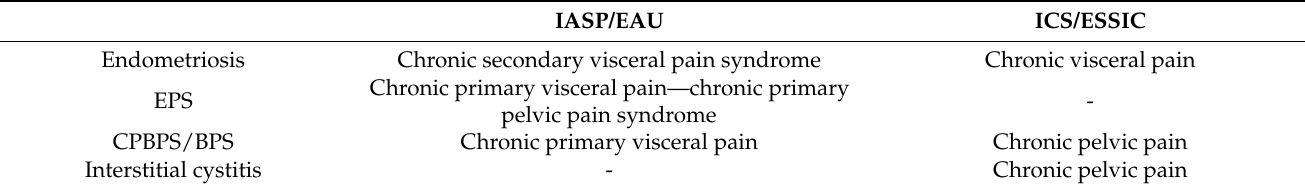
Table 1. Summary of IASP and ICS classifications of pain related to endometriosis, endometrio- sis pain syndrome (EPS), and bladder pain syndrome (BPS) and chronic primary bladder pain syndrome